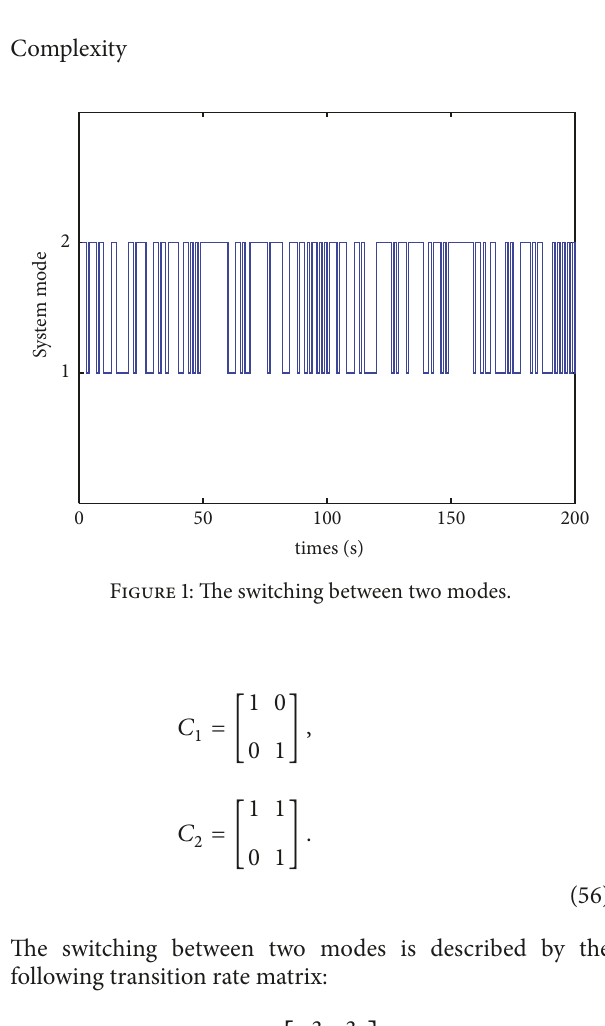
the system is mean-square bounded within the region B